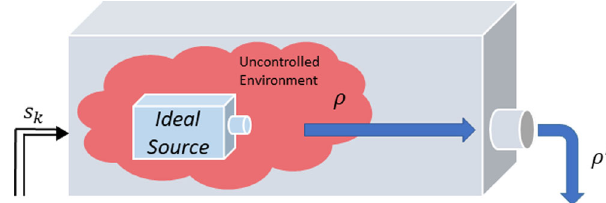
Fig. 2 Finitely correlated strategies. Suppose that a player owns a device which allows them to prepare and distribute a quantum state to the referee. Unfortunately, at each experimental preparation the player ’ s device interacts with an environment A . Explicitly, if the player activates their device, then the referee receives the state tr A ½ ∑ i K i ρ K y i (cid:4) ; where ρ is the current state of the environment and K i : H A ! H A (cid:3) H are the Kraus operators which evolve the environment and prepare the state that the referee receives. Since the same environment is interacting with each prepared state, the states that the referee receives in different rounds are likely